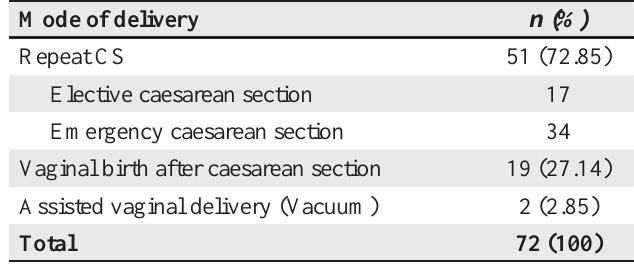
Table 2 . Mode of delivery in women with one previous